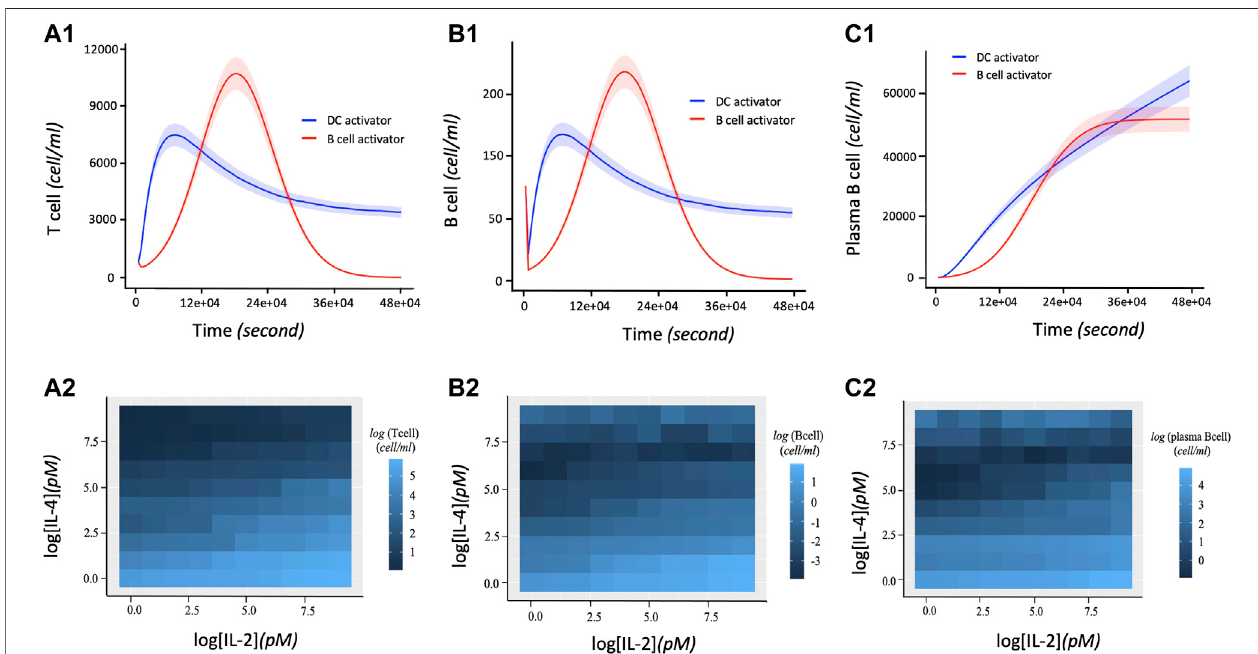
FIGURE 4 | Dynamic pro fi les of lymphocyte immune response with respect to DC and B cell activation protocols. The parameter values (in Eqs 1 – 10 ) used to obtainthesecurvesareshownin Table2 .1.5and15pMconcentrationlevelsofIL-2andIL-4areusedrespectively. (A1) NumberofTcellsproliferationovertimeinterms of independent DC and B cells activators. (B1) Rate of B cell proliferation with regards to DC and B cell activation of the immune system. (C1) Dynamic proliferation of PlasmaBcells with respect tothe DCand Bcell activationsof theimmunesystem. The shaded areaofthe levels ofT cells, Bcells and PlasmaBcells in (A1) , (B1) , and (C1) respectivelyrepresentthe95%con fi denceintervalofthemodelparameters. (A2) HeatmapdescribingtheeffectofthedownregulationofIL-2byIL-4correlates withan increase inTcell proliferation. Ahigh Tcellproliferation isproportionaltolowconcentrationofIL-4andhigh concentrationofIL-2. (B2) Heatmap showingtheco- expression patterns of IL-2 and IL-4 signaling and the B cell proliferation. Initially, high B cell proliferation is obtained with a high concentration of IL-2 and low concentration ofIL-4. Due totheabilityofIL-4 toco-stimulate Bcellproliferation(Idzerda etal., 1990),anextreme highconcentration ofIL-4 presents aslight increase of B cells proliferation. (C2) Heatmap describing the joint effect of the downregulation of IL-2 by IL-4 on the dynamical proliferation of Plasma B cells. High Plasma B cell proliferation correlates more with low concentration of IL-4 and high concentration of IL-2. However, like B cell, it also displays a slight increase of its proliferation at high concentration of IL-4 considered as co-stimulator of B cell proliferation.